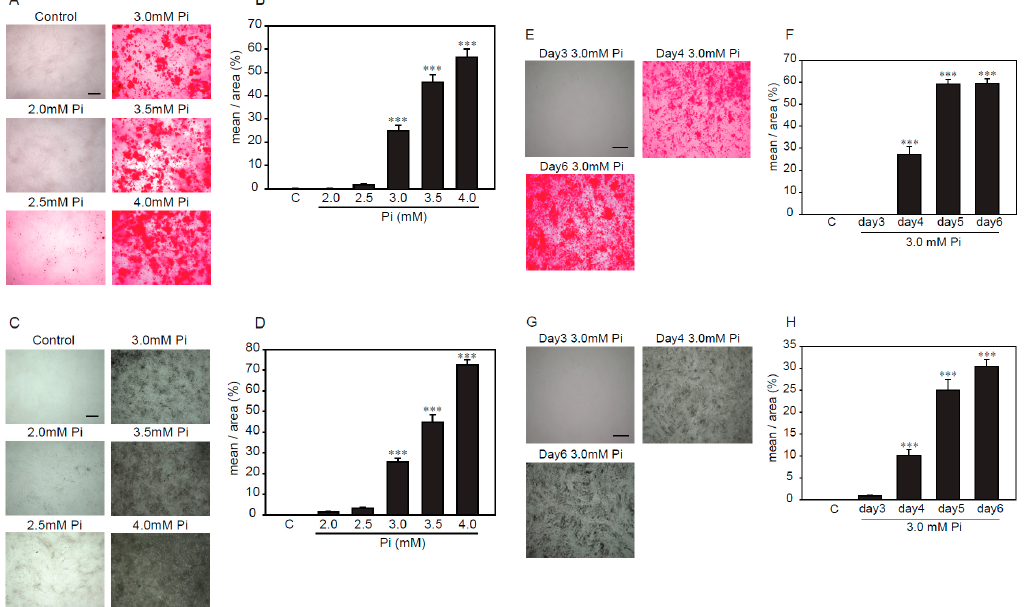
Figure 2. Determination of calcification conditions in p53LMAco1 cells. ( A – D ) p53LMACO1 cells were cultured under high concentrations of Pi (2.0–4.0 mM) for 6 days. ( E – H ) p53LMACO1 cells were cultured with 3.0 mM Pi for 3–6 days. Alizarin red staining ( A , B , E , F ) and von Kossa staining ( C , D , G , H ) were used to semi-quantitatively investigate calcification. C: Control (1.0 mM Pi), *** p < 0.001 vs. Control Scale bar: 500 μ m.